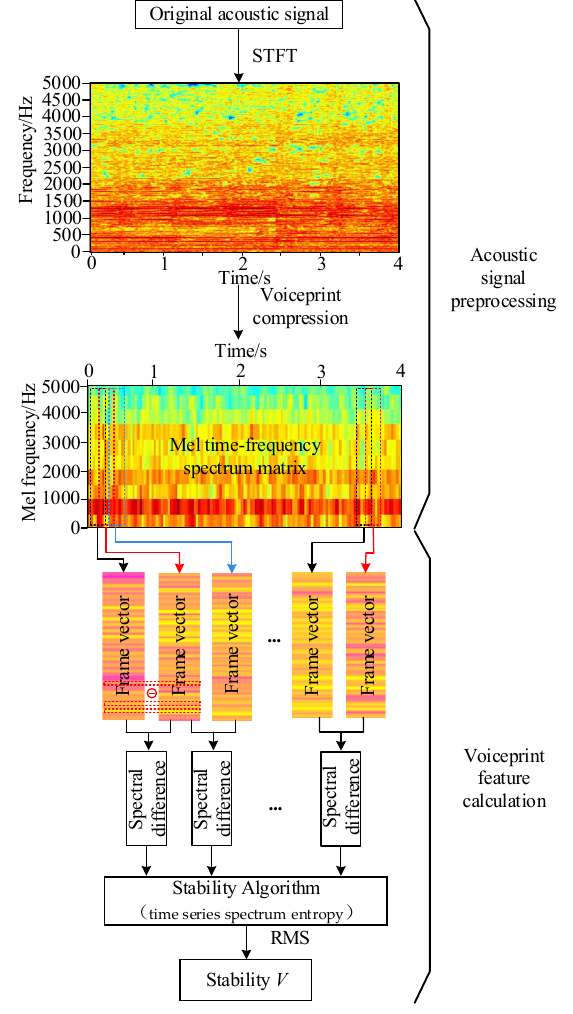
Figure 4. Calculation method for the stability of time-series spectral